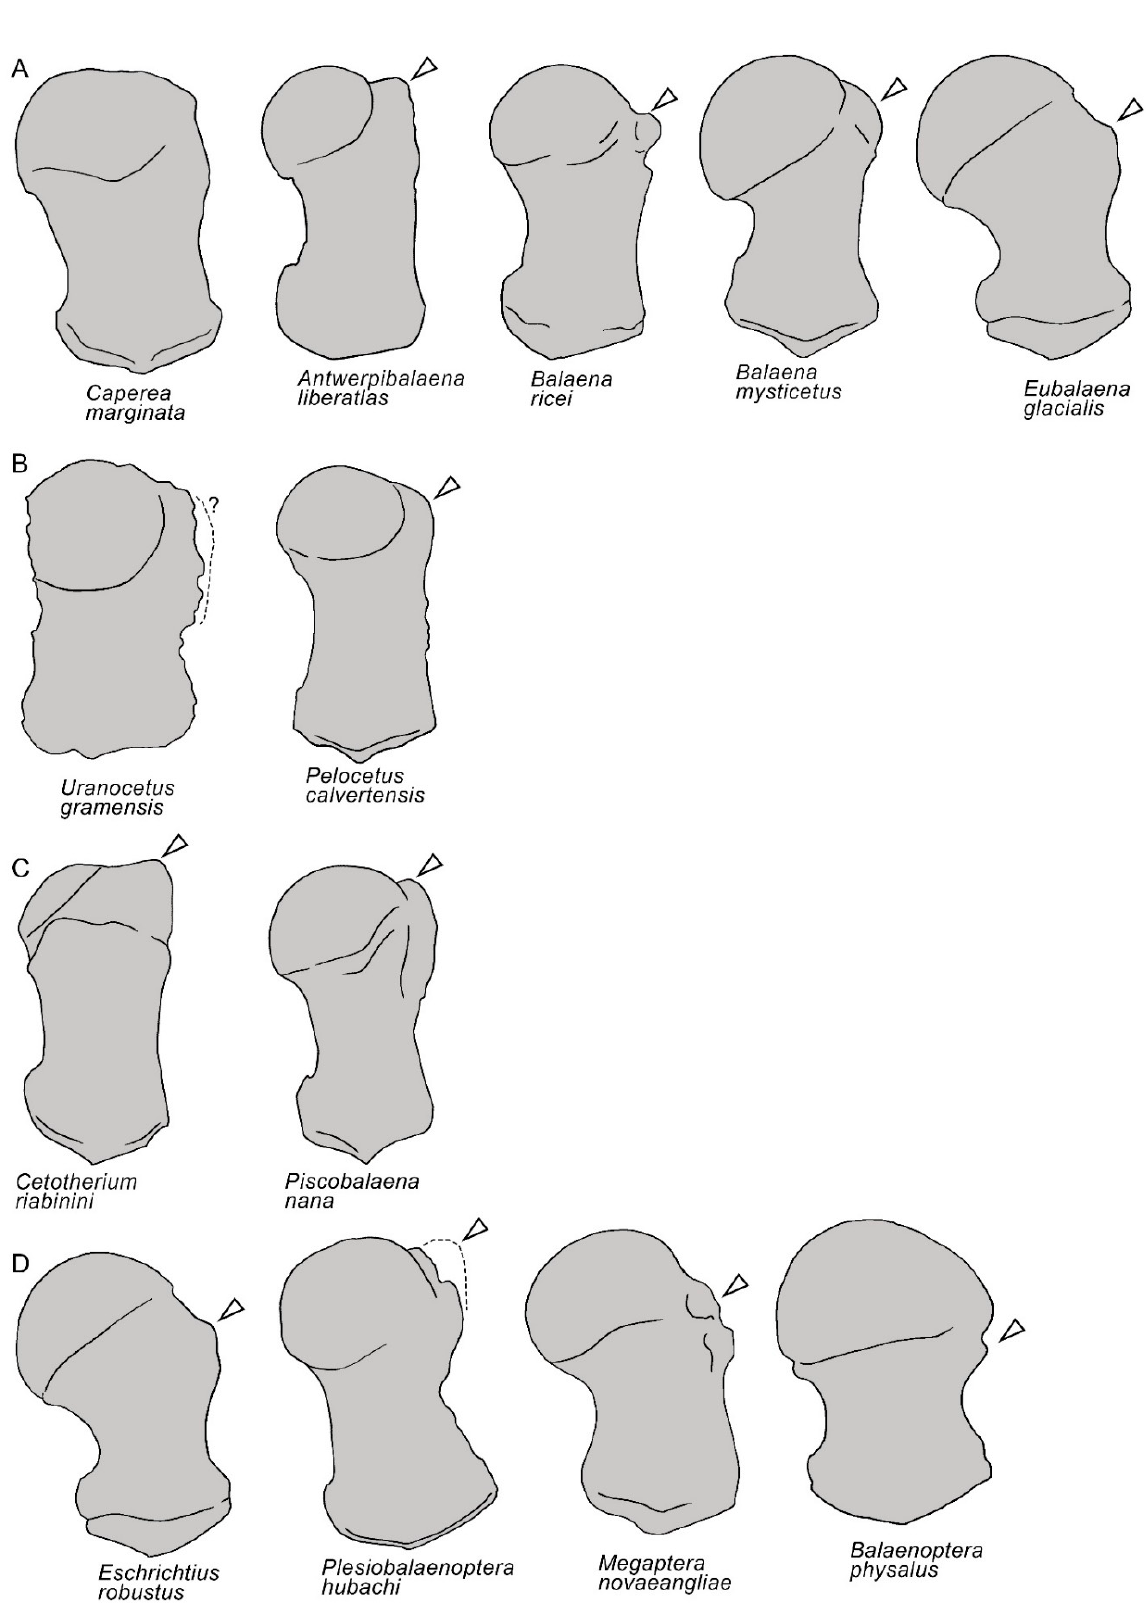
Figure 23. The humerus of balaenomorph mysticetes. ( A ) Balaenoidea. ( B ) Basal thalassotherian taxa. ( C ) Cetotheriidae. ( D ) Balaenopteroidea. The white triangle indicates the greater tubercle of the humerus. Not to scale. The scapulae are represented as if they shared the same anteroposterior length.